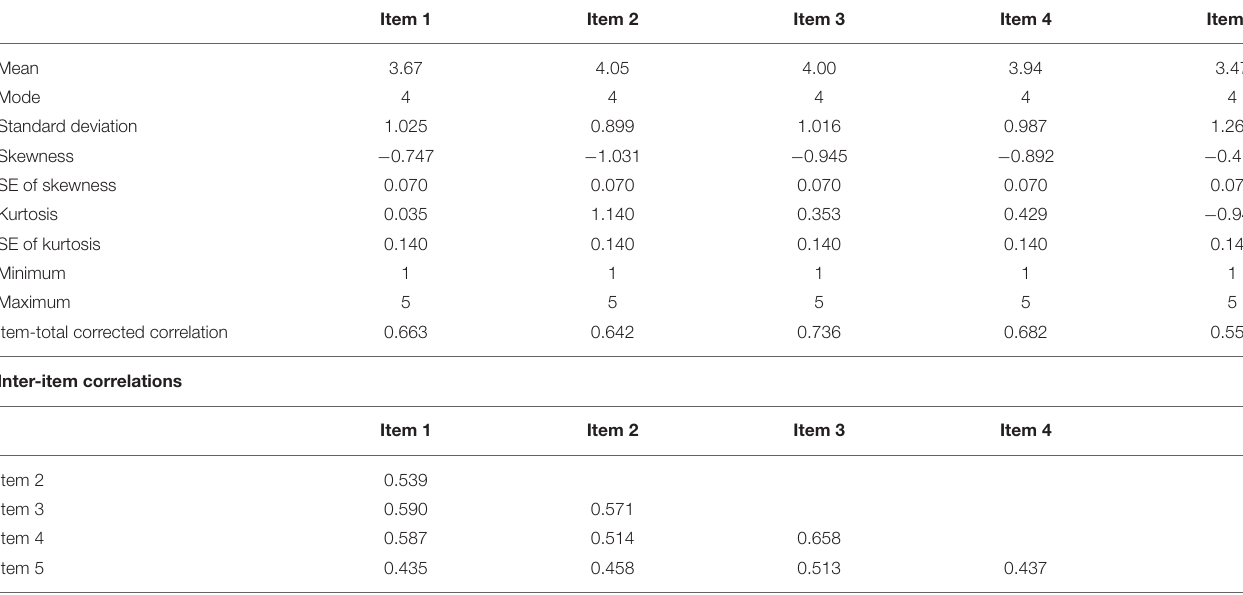
TABLE 2 | Descriptive statistics, item-total corrected correlations, and inter-item correlations among the items (Valid N = 1,222).